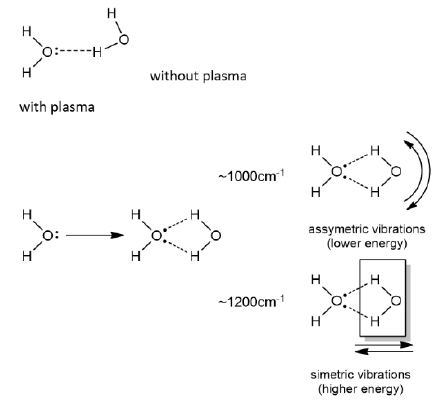
Figure 6. Proposed building macrostructure water–water interactions responsible for developing ~1200 and ~1000 cm − 1 FTIR-ATR bands.